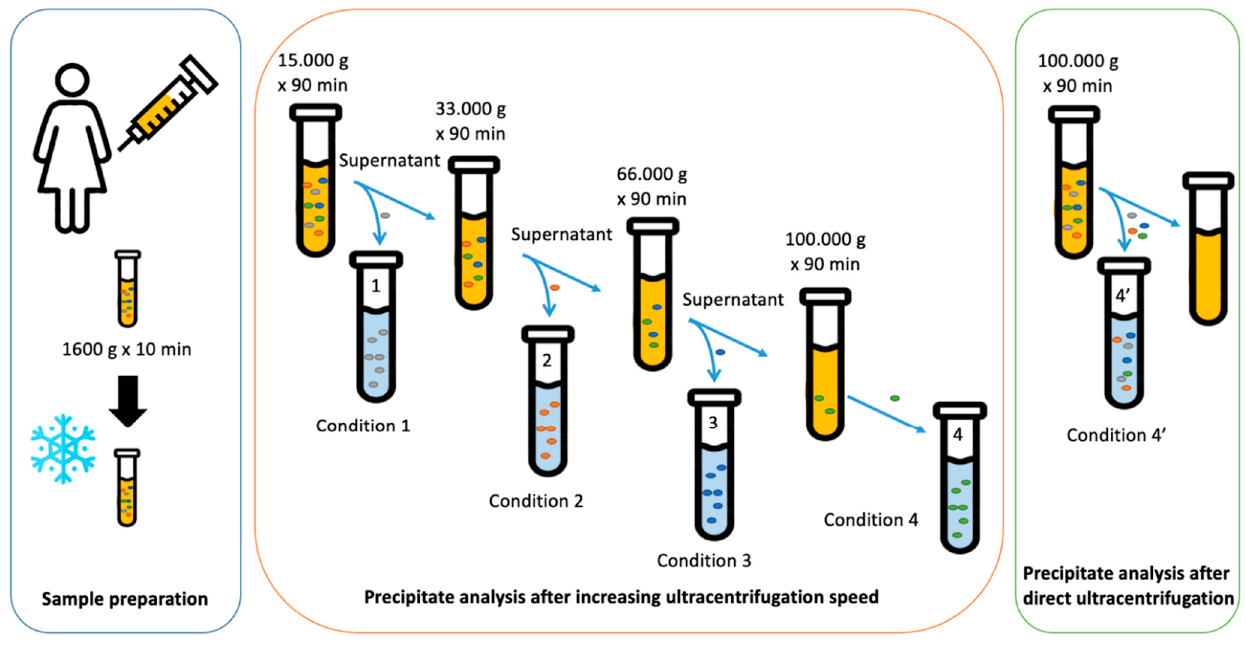
Figure 1. Schematic view of the protocols to separate the different subclasses of EVs in FF. The NTA technique permits to evaluate the particle concentration and diameter under each